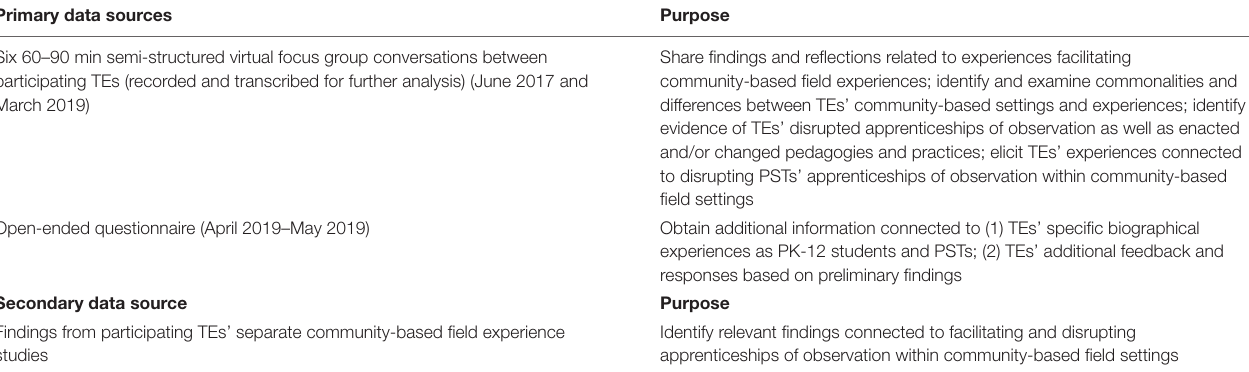
TABLE 3 | Data sources.